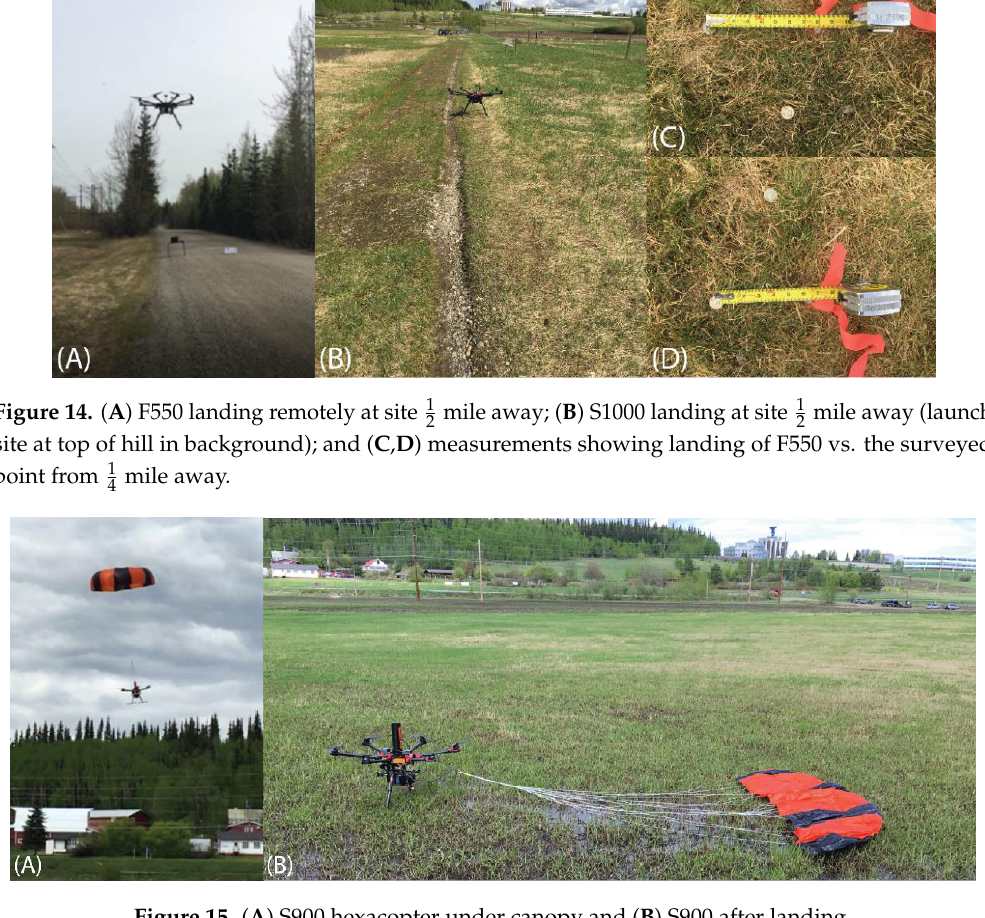
Figure 14. ( A ) F550 landing remotely at site ½ mile away; ( B ) S1000 landing at site ½ mile away (launch site at top of hill in background); and ( C ), ( D ) measurements showing landing of F550 vs. the surveyed point from ¼ mile away.